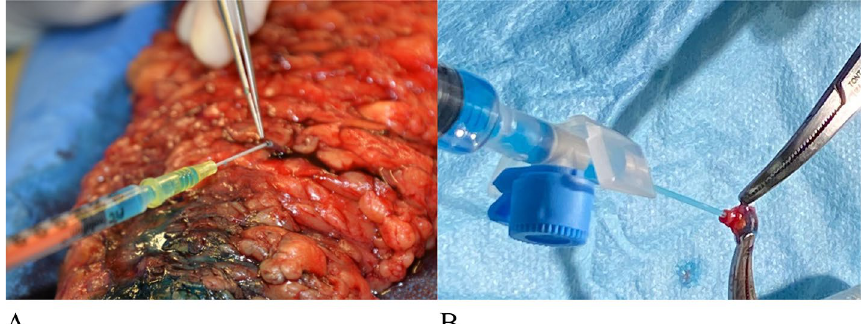
Figure 1. Fixative flush infused into the lymphatic vessel ( A ) and into the vein ( B ).